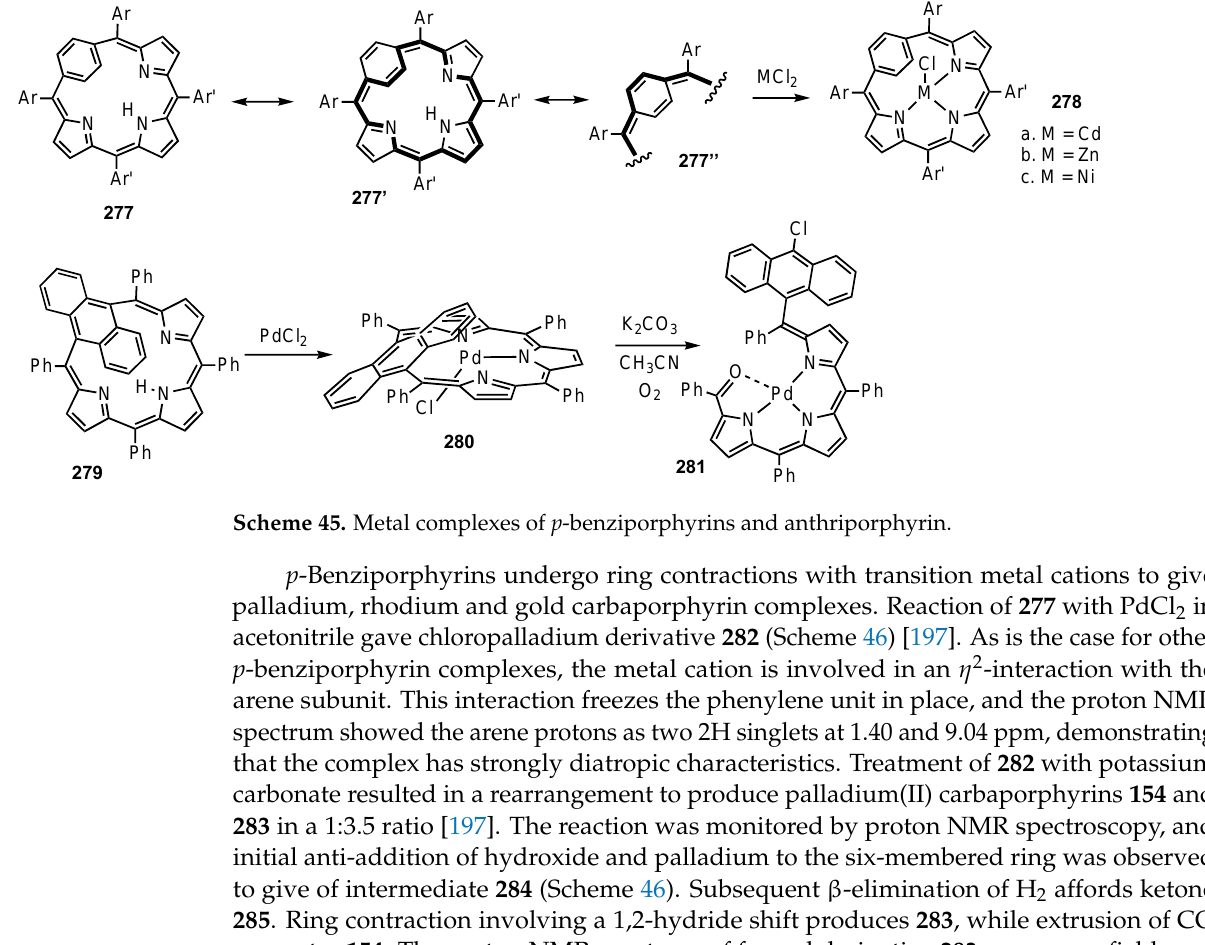
sium carbonate resulted in a rearrangement to produce palladium(II) carbaporphyrins 154